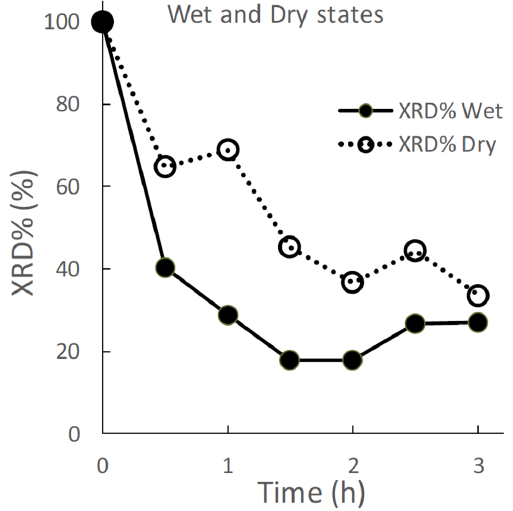
Figure 2. Effect of wet and dry grinding on the XRD %area (XRD%) of the ground S-CP products.